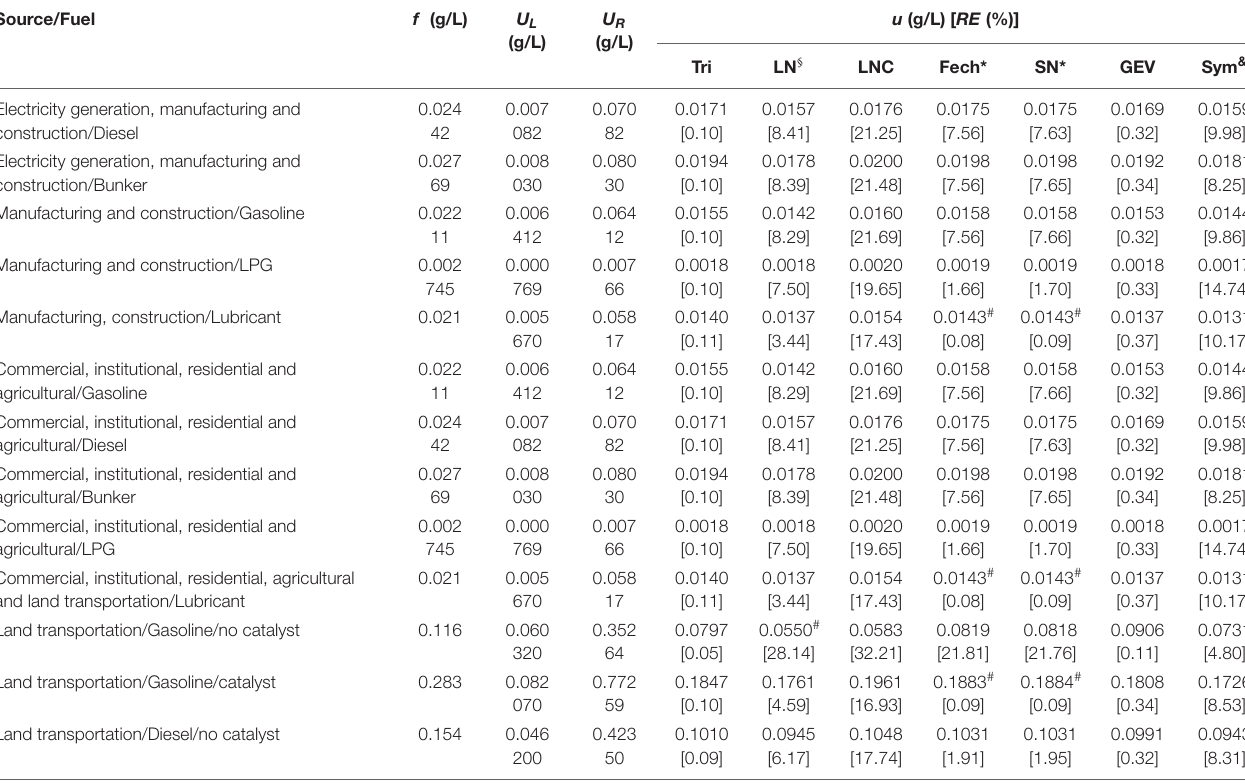
TABLE 3 | Absolute standard uncertainties u and largest relative error RE estimated for N 2 O emission factors for the fuel sector using various asymmetric approaches. The best estimate f and expanded asymmetric uncertainties U L and U R were taken from the official database of Costa Rican emission factors (IMN, 2020). Values of RE are shown inside the